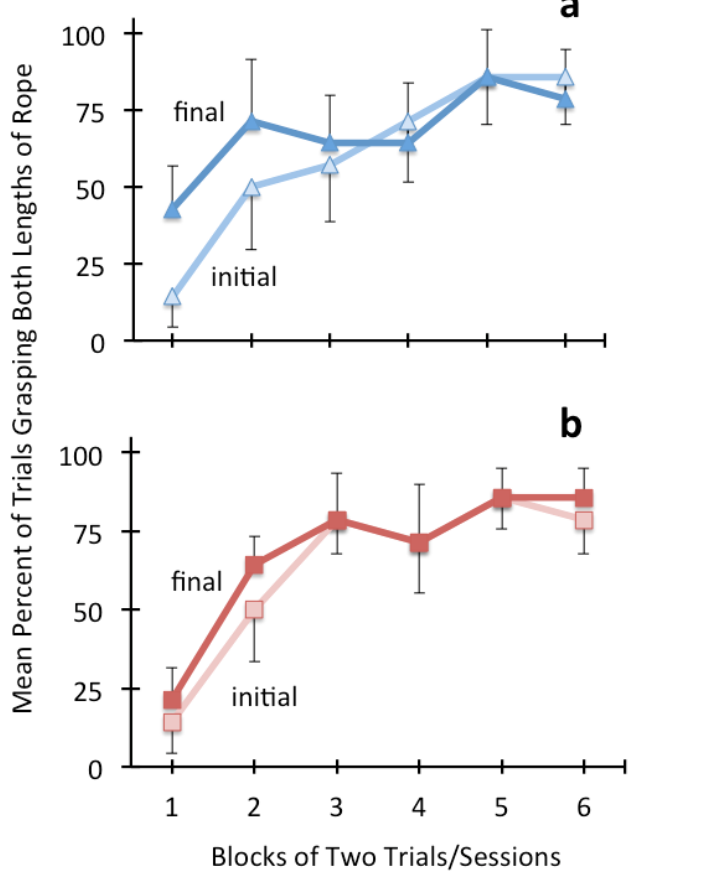
The Mean Percent of Trials (± SEM) in Which the Apes’ Initial and Final Actions Involved Grasping Both Lengths of Rope, in the (a) Loop and (b) Untied